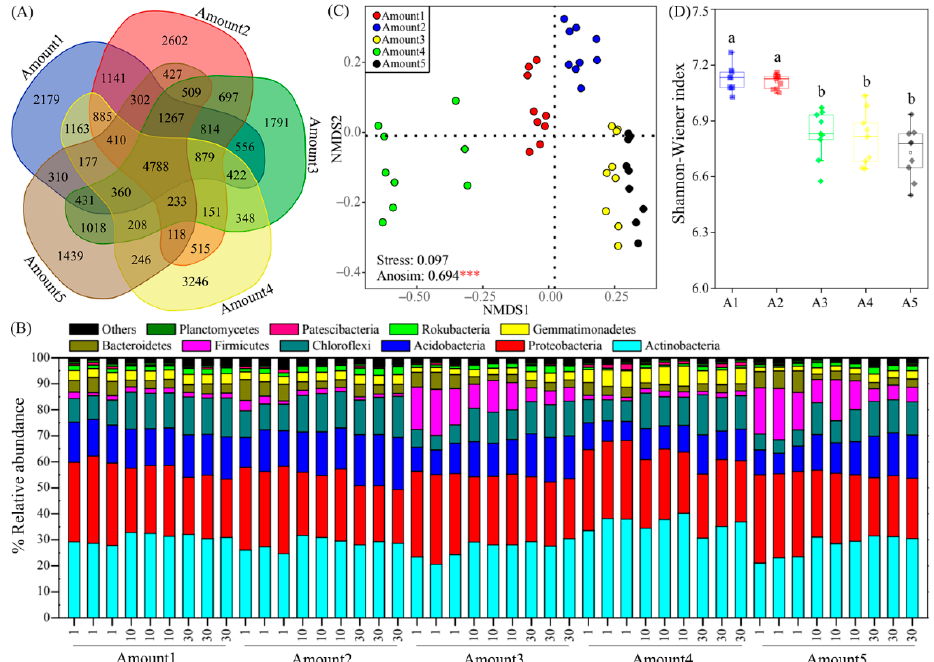
Figure 6. Composition and diversity of the bacterial community in sediments. The Venn diagram shows the shared OTUs of bacteria in five groups with different TiO 2 NP addition amounts ( A ). Relative abundance of the top ten phyla. Numerical numbers (i.e., 1, 10, and 30) denote the incubating time ( B ). The nonmetric multidimensional scaling plot reflects the bacterial community composition among the five groups. Asterisks denote significance (***, p < 0.001) ( C ). Differences in bacterial taxonomic α -diversity (Shannon–Wiener index) among five groups with different TiO 2 NP addition amounts. Different letters denote differences ( p < 0.05) ( D ).